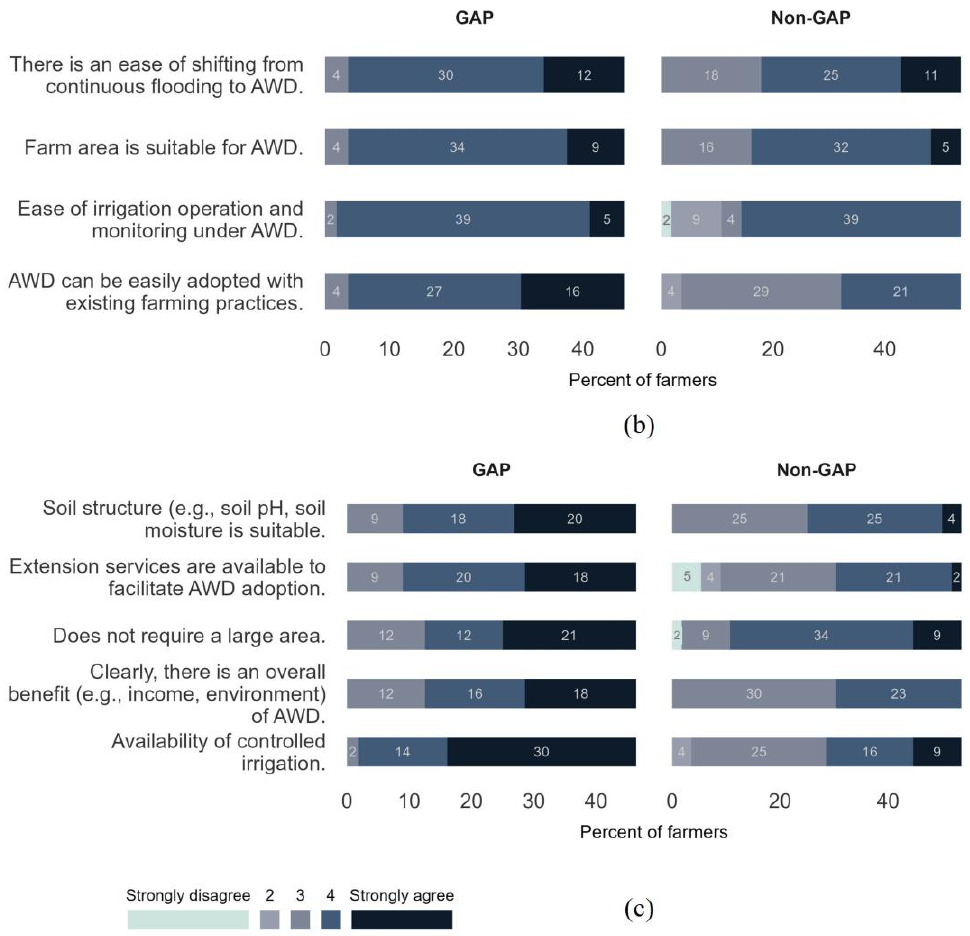
Figure 2. GAP and non- GAP farmers’ perceptions of AWD adoption intention regarding the ( a ) innovation advantages, ( b ) ease of adoption, and ( c ) trial capability